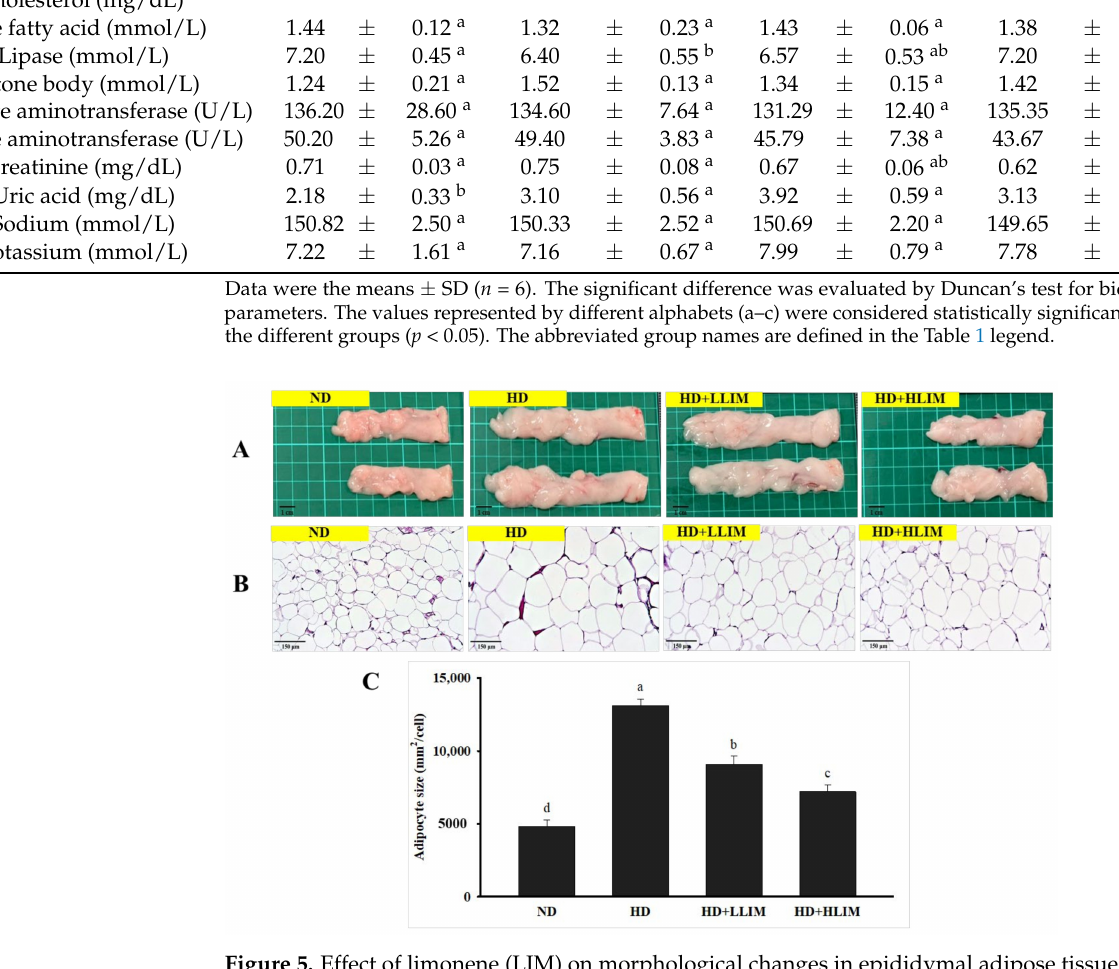
Figure 5. Effect of limonene (LIM) on morphological changes in epididymal adipose tissues of high- calorie diet-induced obese rats. ( A ) Histological observation. ( B ) H&E-stained epididymal adipose tissue sections. ( C ) Epididymal adipose size. Epididymal adipose tissue was stained with H&E and viewed under a microscope ( × 200). Data were the means ± SD ( n = 6). The values represented by different alphabets (a–d) were considered statistically significant between the different groups ( p < 0.05). The group names abbreviated are defined in Table 1